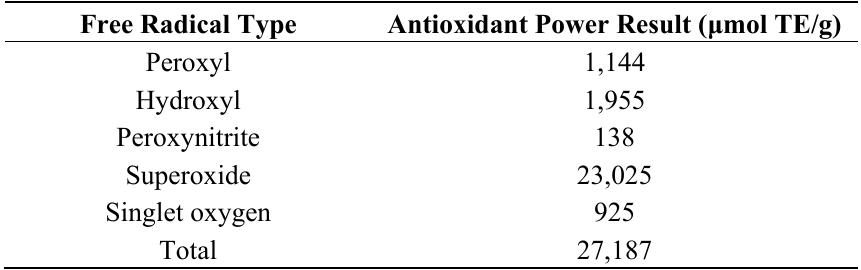
Table 5. ORAC5.0 assay results for Fucus vesiculosus